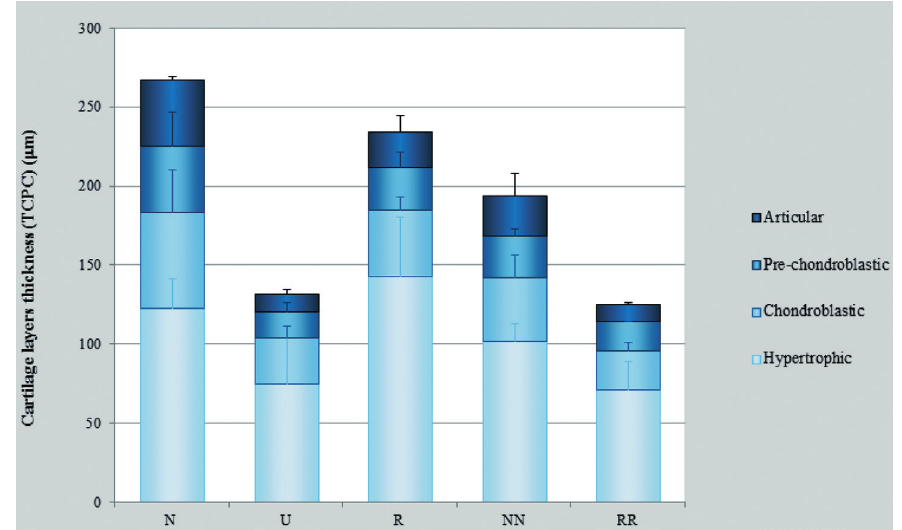
Figure 4- Analysis of mandible condylar process cartilage layers thickness (TCPC)